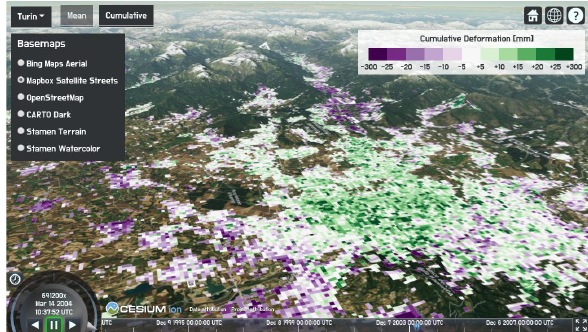
Figure 6. A raster layer of cumulative deformation